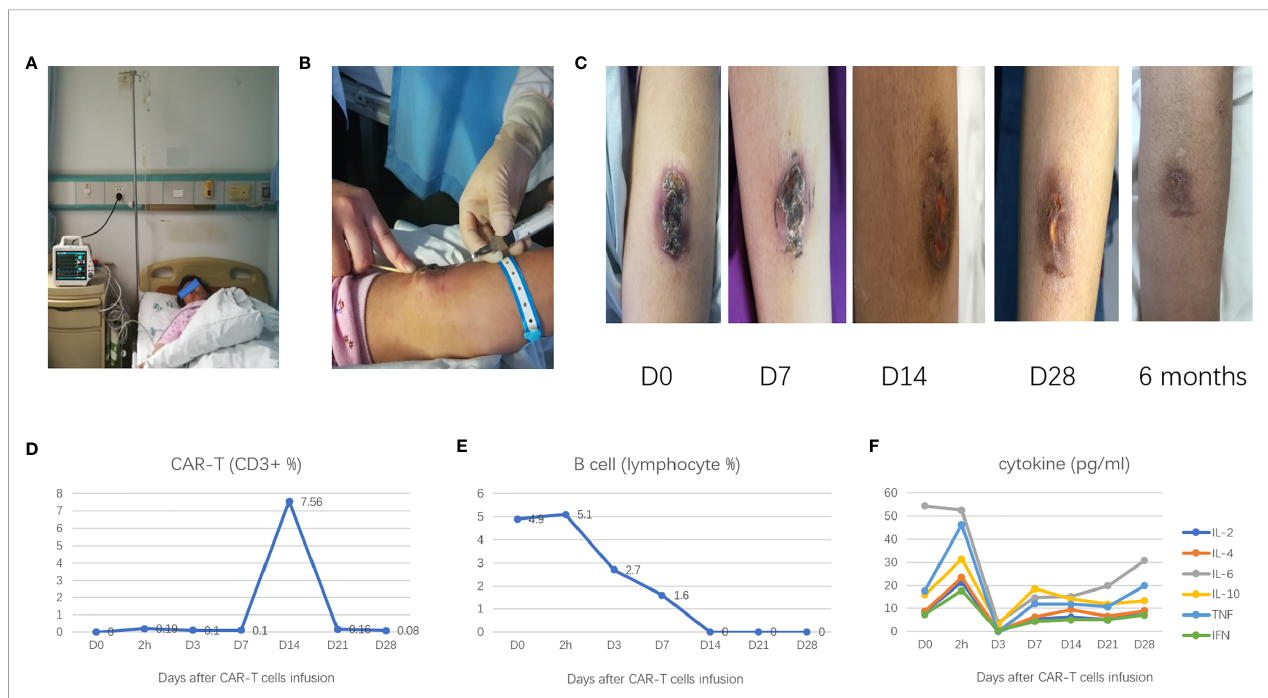
FIGURE 2 | (A) intravenous infusion of CAR-T cells; (B) local injection of CAR-T cells; (C) the changes of mass after CAR-T cell treatment; (D) the CAR-T cell kinetics during the treatment process; (E) B cell depletion during the treatment process; (F) Change in cytokines levels during the treatment